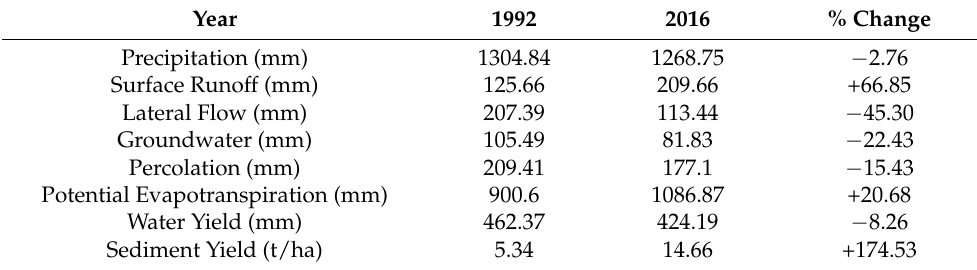
Table 4. Impact of LULC change on the water balance components in the Yellow Creek Watershed.